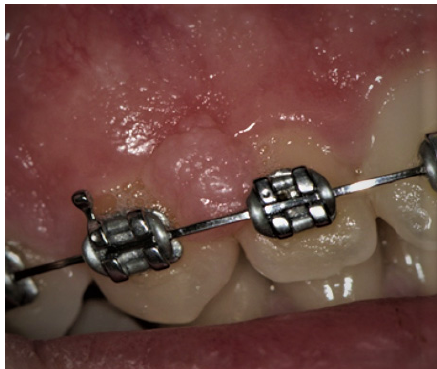
Figure 9. Papilloma of the interdental papilla between teeth 12 and 13 in adolescent girls. Papilloma is a soft, painless, pedunculated, exophytic nodule with uneven surface. Usually, it is a solitary lesion. In this patient, it has blunted projection and a pale-pink color.